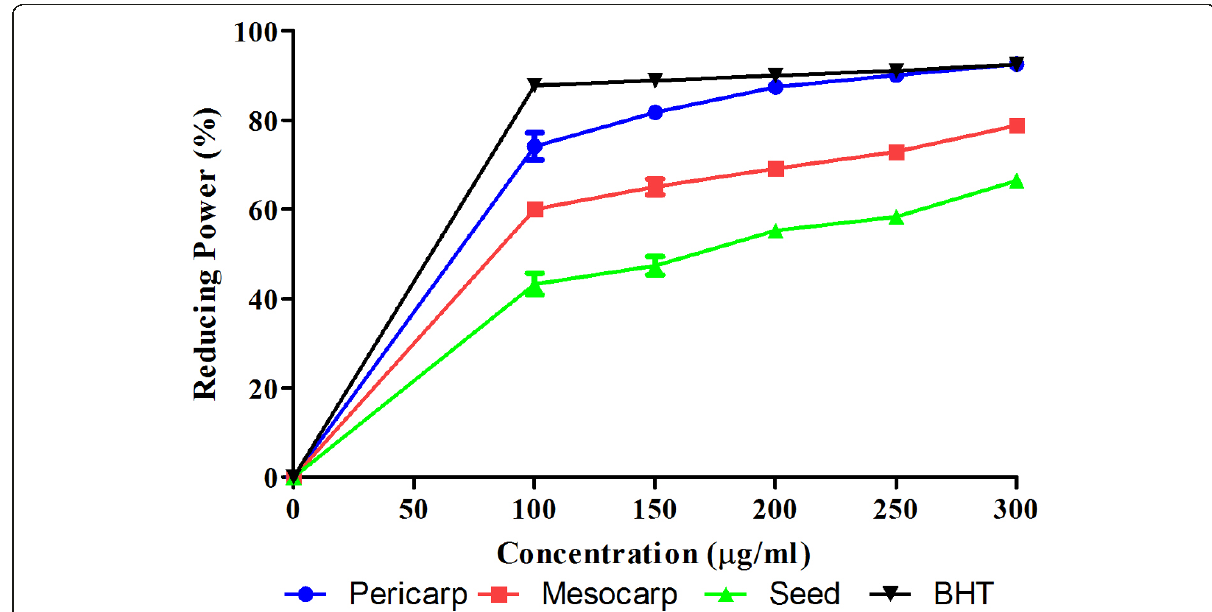
Figure 4 Reducing power activity of extracts at different concentrations . Values are mean ± S.E.M. of three